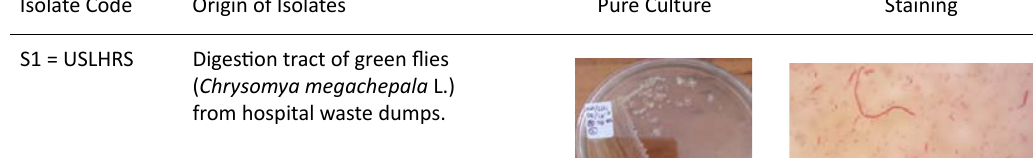
table 4. Bacterial isolates from the digestive tract of green flies and wing house flies in Luwuk city. Isolate Code Origin of Isolates Pure Culture Staining S1 = USLHRS Digestion tract of green flies ( Chrysomya megachepala L.) from hospital waste